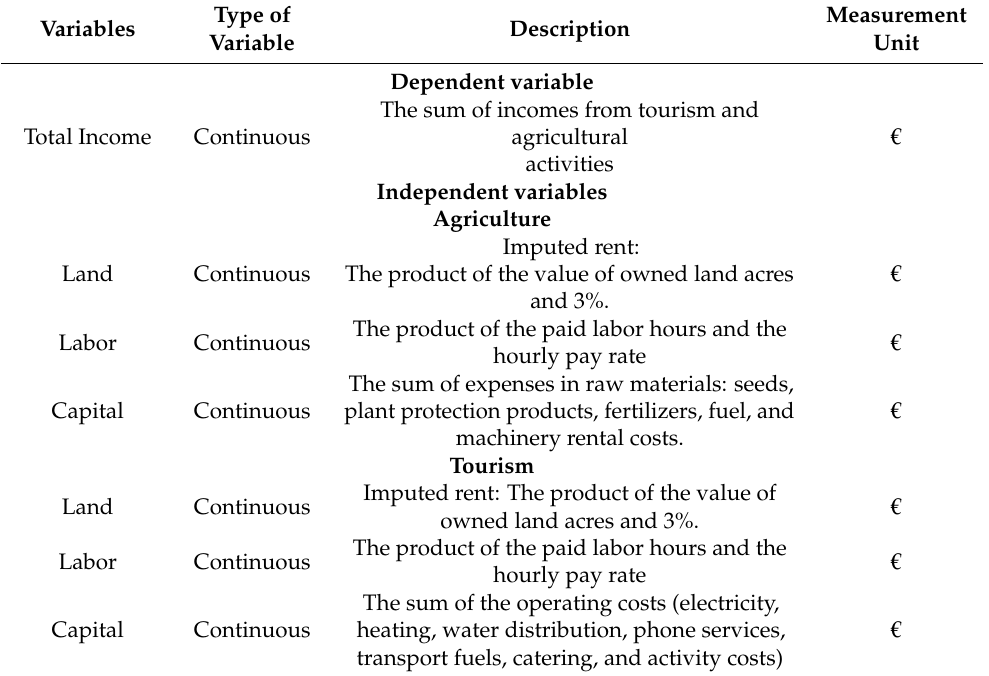
Table 1. Variables’